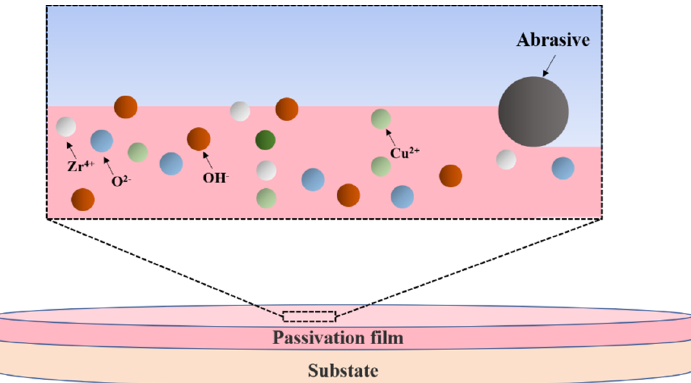
Figure 11. Schematic illustration of the material removal